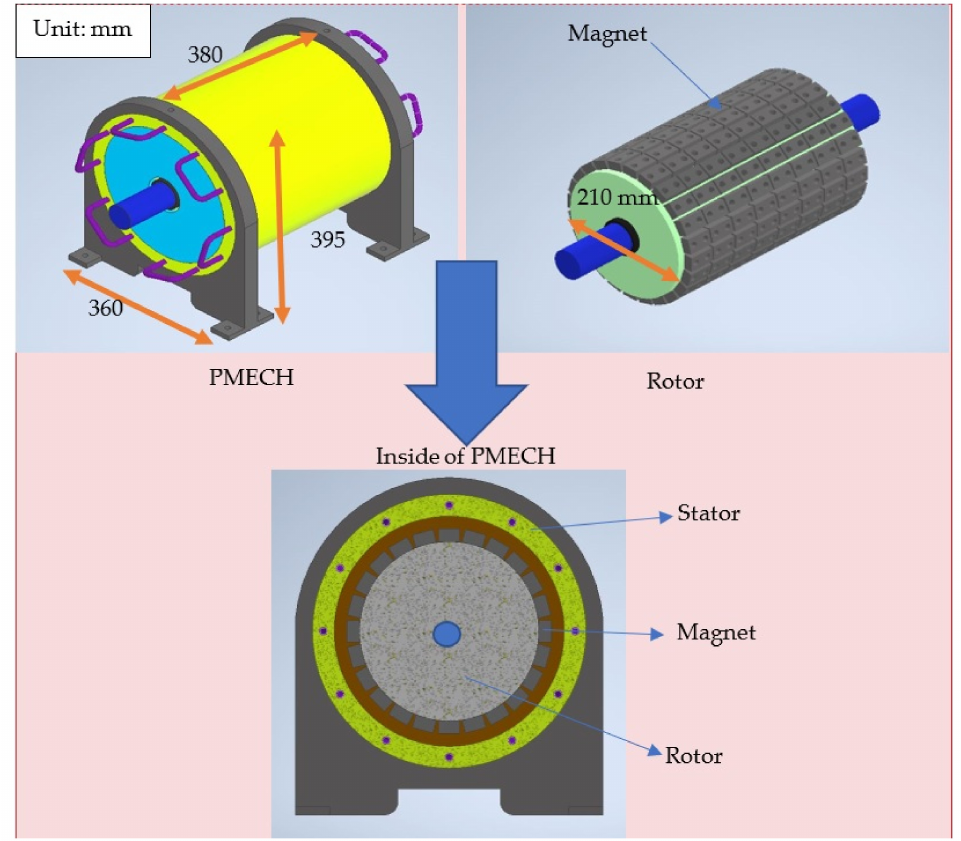
Figure 3. 3D prototype of